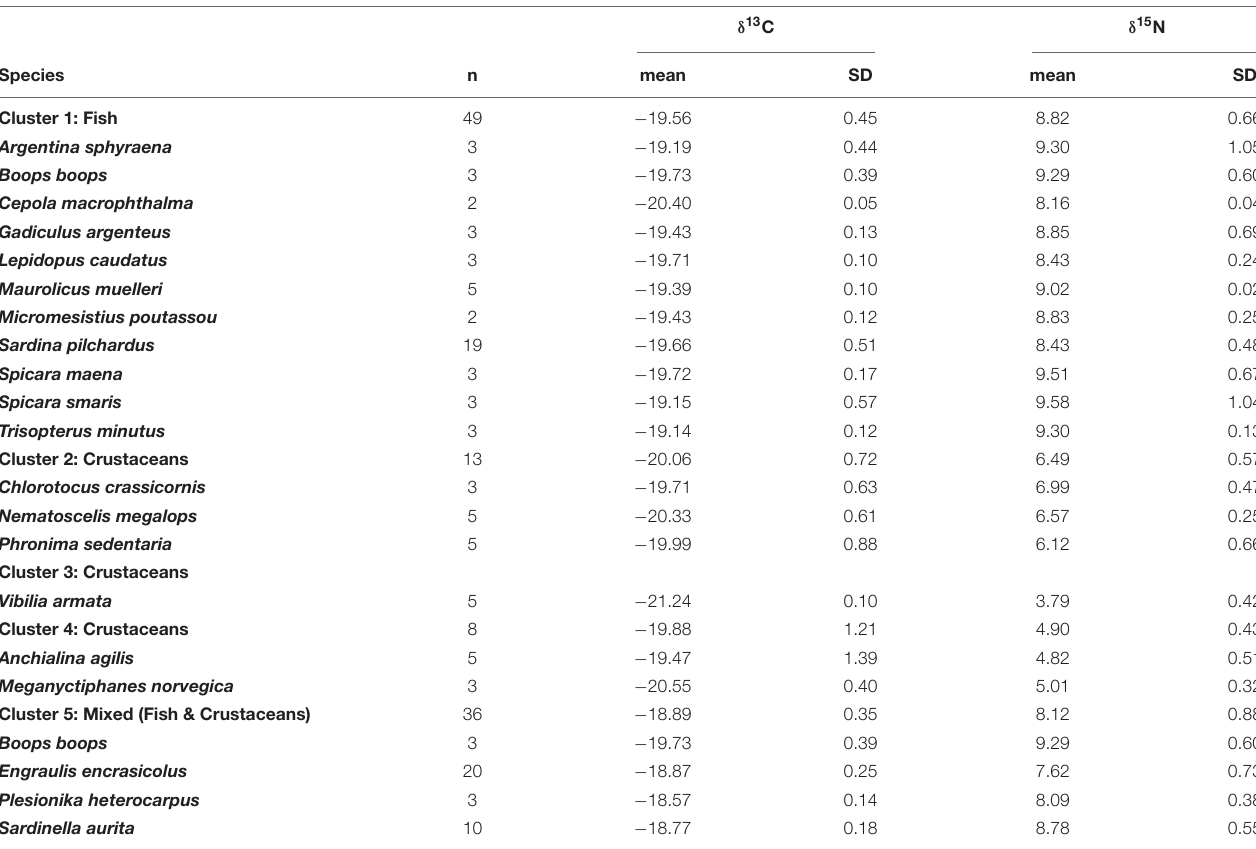
TABLE 6 | Number of samples, mean, standard deviation (SD) of δ 13 C and δ 15 N values of the prey used in the Bayesian mixing models to estimate the diet of European